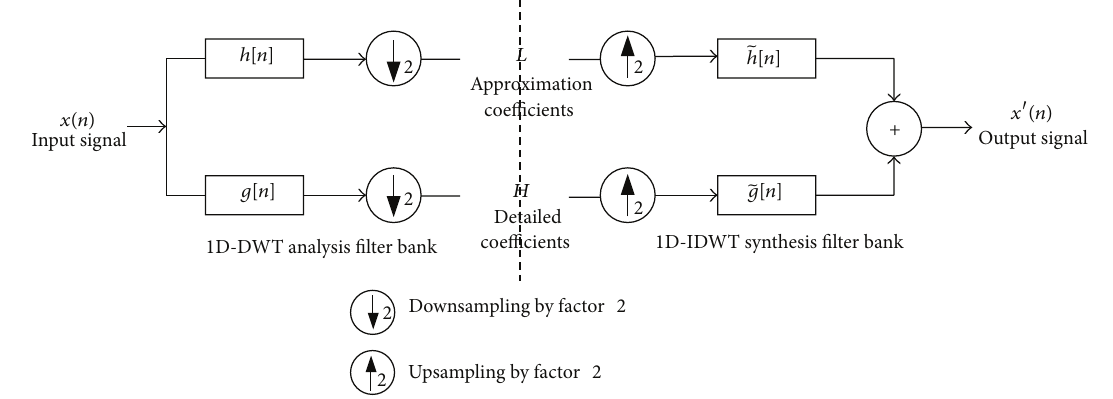
Figure 1: Single level wavelet transforms using convolution